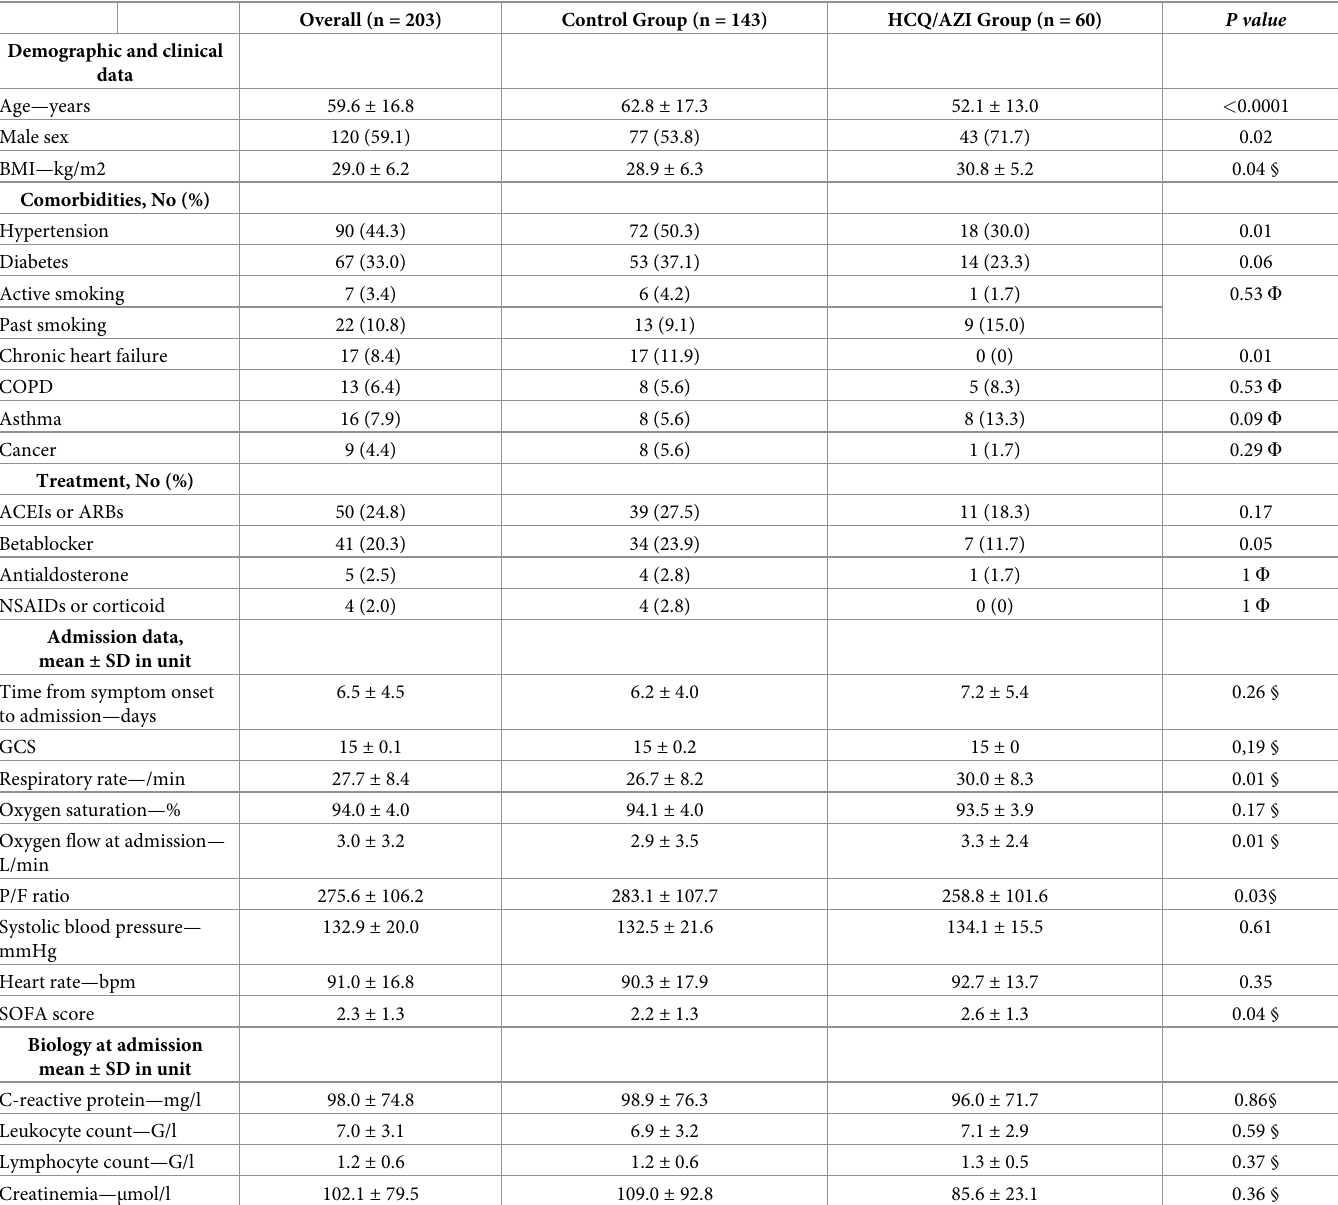
Table 1. Demographic and clinical characteristics of the patients at baseline. Unless noted otherwise, parametric comparisons were